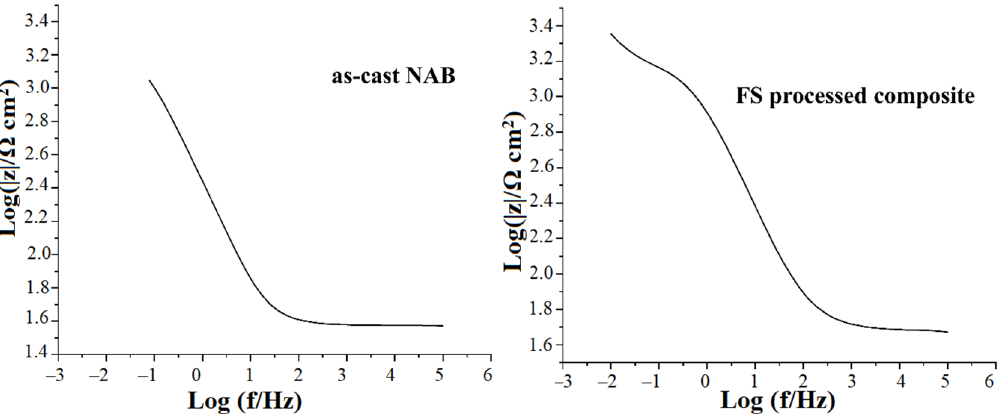
Figure 18. Bode plot for as-cast NAB alloy and FS-processed composite in 3.5 wt.% NaCl solutions.